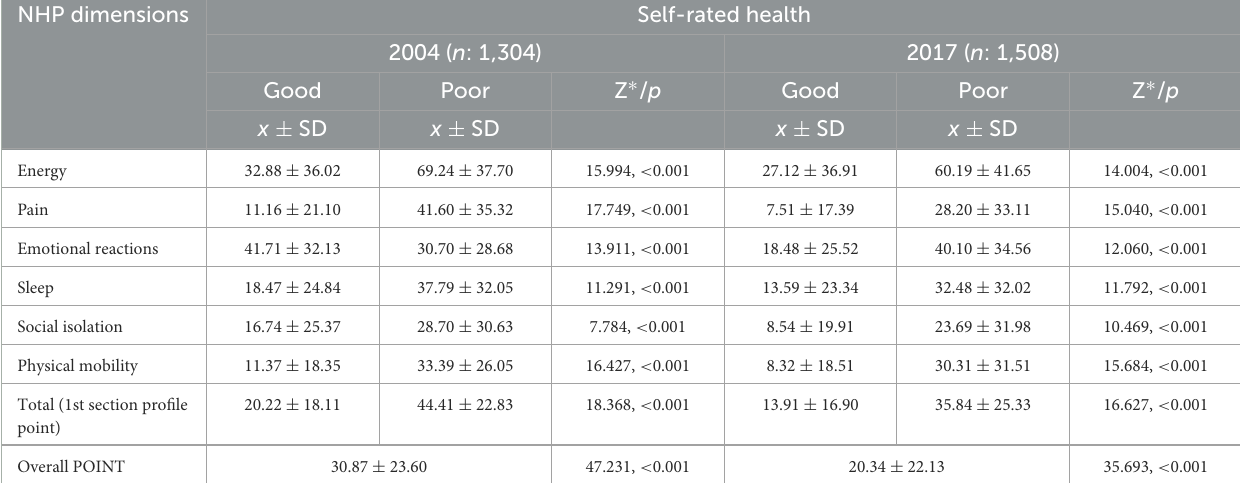
TABLE 5 Nottingham Health Profile Scores in patients aged 15 and over according to their self-rated health (SRH) at